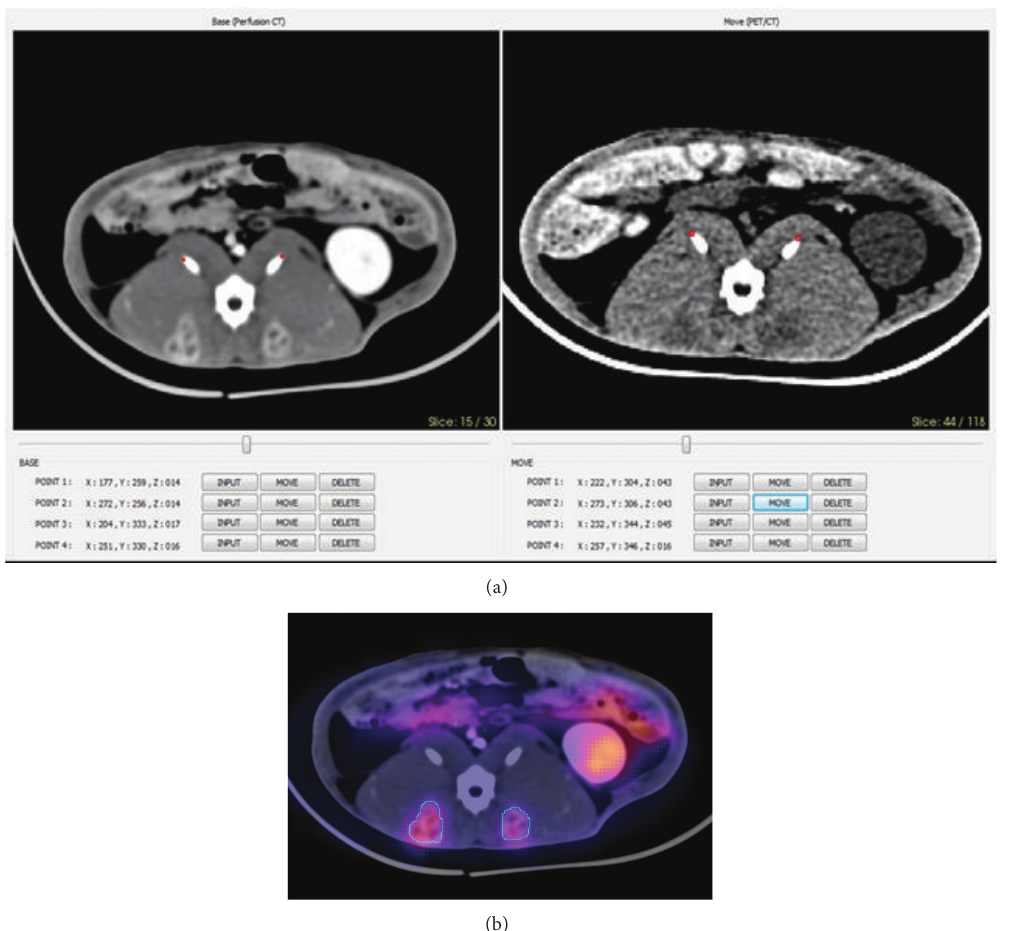
Figure 1: Coregistration of perfusion CT and PET images on day 7: rabbit number 3 in the control group. (a) A contrast-enhanced CT image from the thirty-first frame (time point) of perfusion CT and noncontrast CT image from PET/CT acquisition were coregistered to the same locations. (b) PET and coregistered perfusion CT images were rigidly fused using in-house developed software and ROIs were manually delineated throughout the whole tumor at each axial